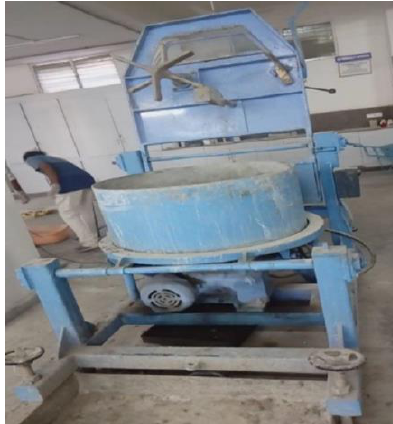
Fig. 1. Pan mixer Used for concrete Blending.